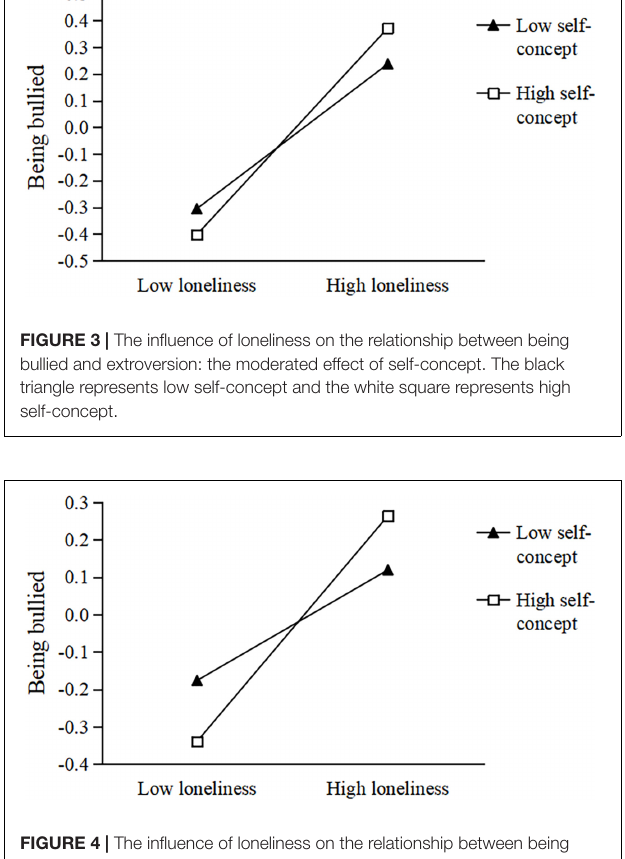
FIGURE 4 | The influence of loneliness on the relationship between being bullied and agreeableness: the moderated effect of self-concept. The black triangle represents low self-concept and the white square represents high